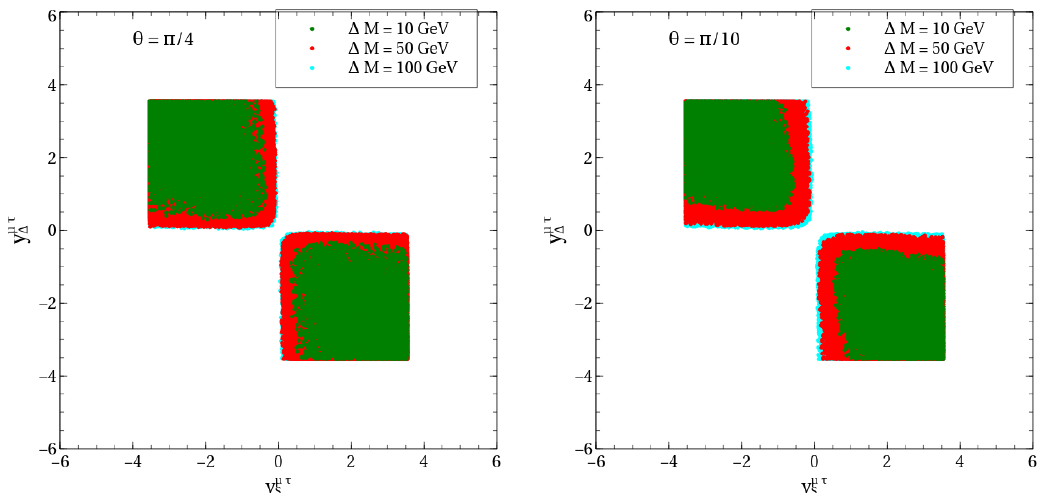
y (cid:22)(cid:28) (cid:1) (cid:0) S